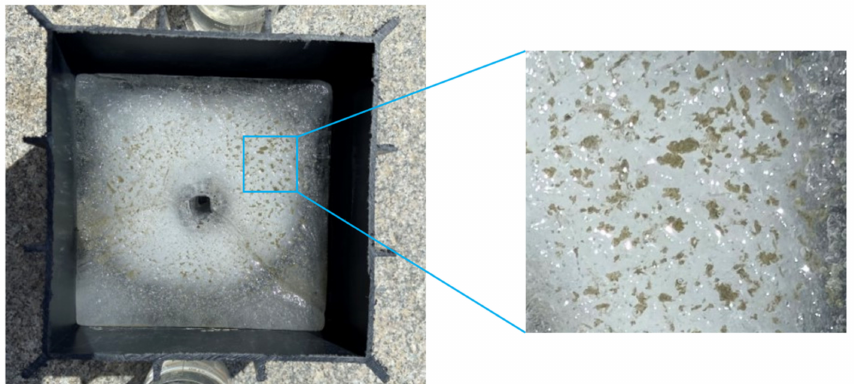
Figure 10. The accumulation phenomenon of small particle size mineral